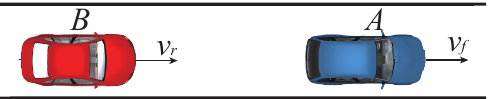
Figure 3. The phases decomposition for lane change.